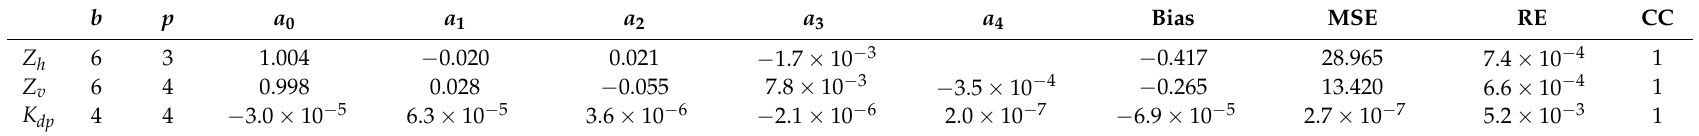
Table 2. Coefficients of the polynomial fits for Z h , Z v , and K dp and metrics for the polynomial fits. MSE, mean square error; RE, relative error; CC, correlation